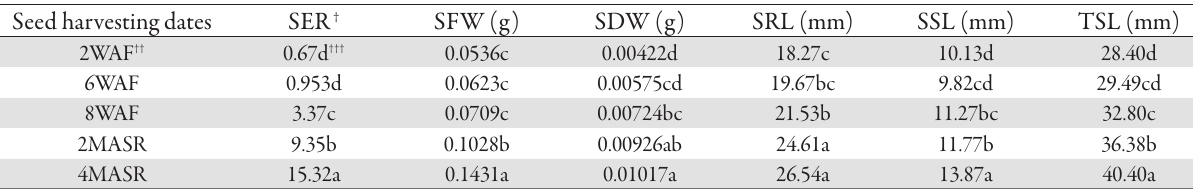
Tab. 2. Mean comparison of seedling traits of R. turcomanicus Czerep, as affected by different seed harvesting times